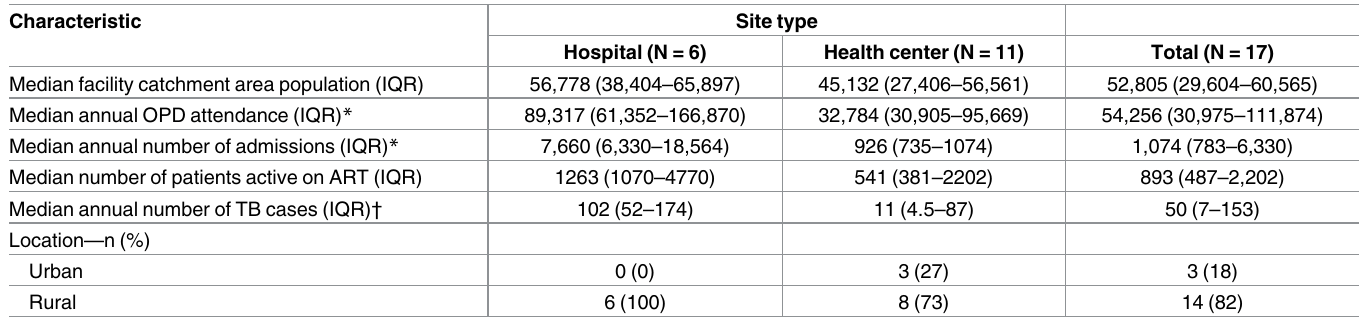
Table 1. Characteristics of survey sites.